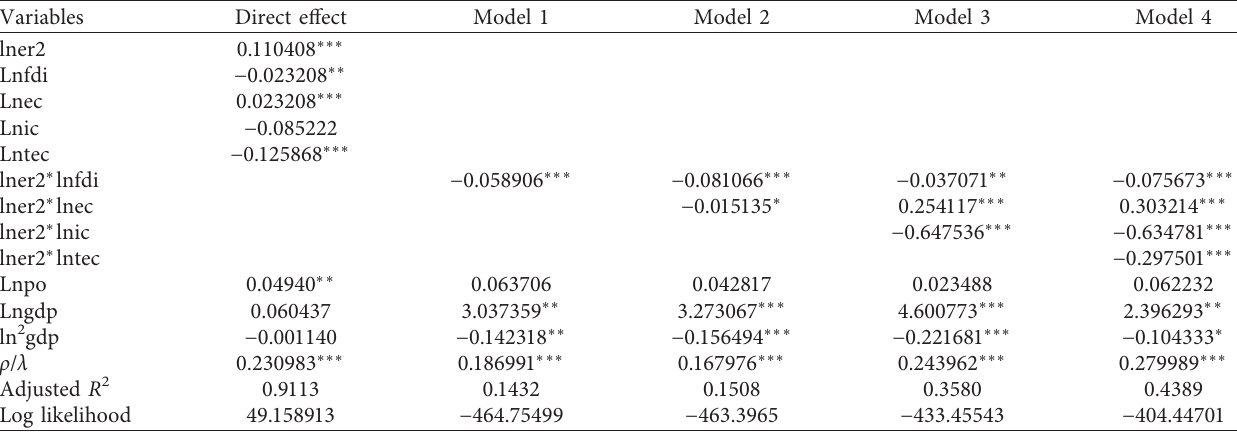
Table 6: Robustness test